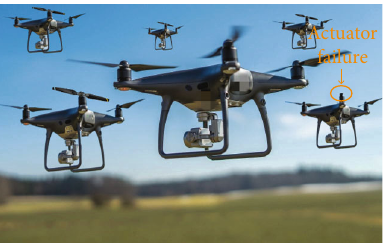
Figure 2: Component failure (e.g., actuator fault) in the UAV